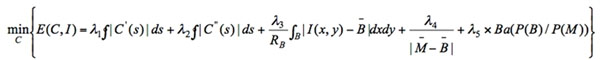
Energy function of the deformable model. C(s)=(x(s),y(s)) is the parameterized contour (endo- and epicardial), P(B) is the histogram of blood pool and P(M) as the histogram of myocardium. Ba(f/g) is the Bhattacharyya coefficient measuring the amount of overlap between two statistical samples f and g. Shape is the Fourier descriptors of the discretized contour. Each contour is constrained by the corresponding cine contour shape, and by myocardial thickness.